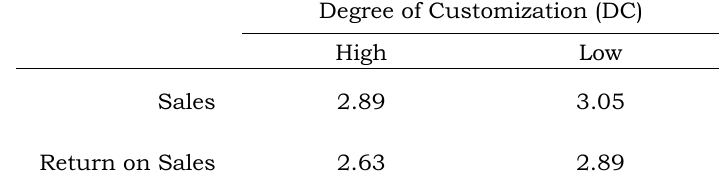
Table 7. Average sales and return on sales in high/low DC